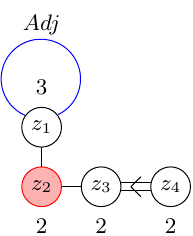
Figure 34 . P (3) quiver with A 1 (cid:2) C 2 global symmetry, b = 1, dim M H [3]